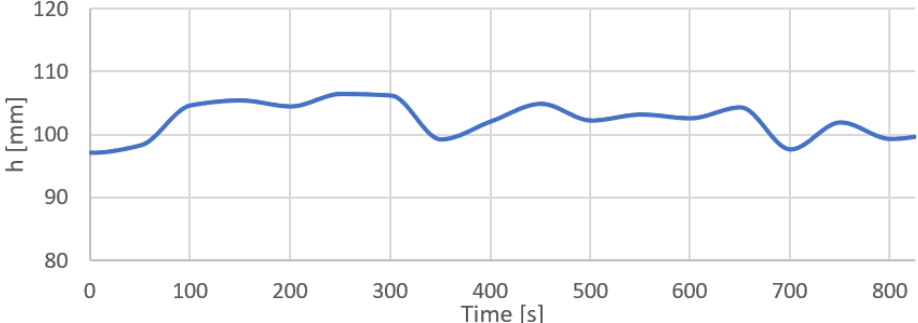
Figure 6. Waveform of changes in the position of the distribution layer in compartment 2 when using the traditional PID controller.